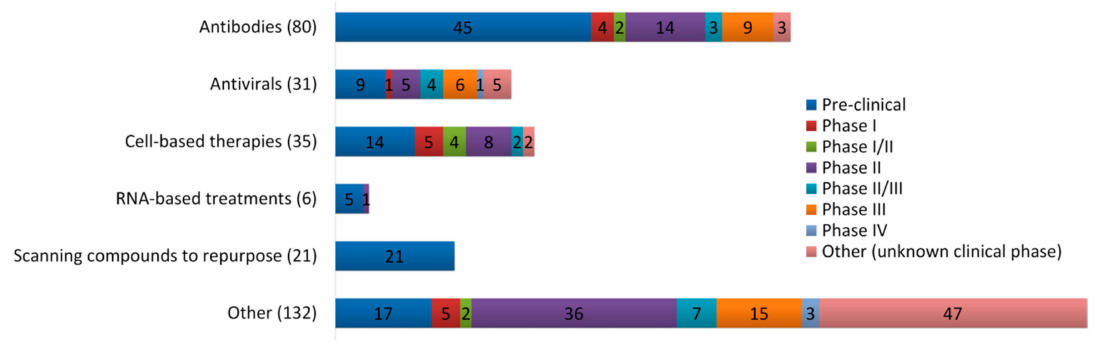
Figure 2. Classification of therapeutic substances being assessed in clinical trials, 305 trials in di ff erent stages, against COVID-19, according to ‘Milken institute COVID-19 treatment and vaccine tracker’